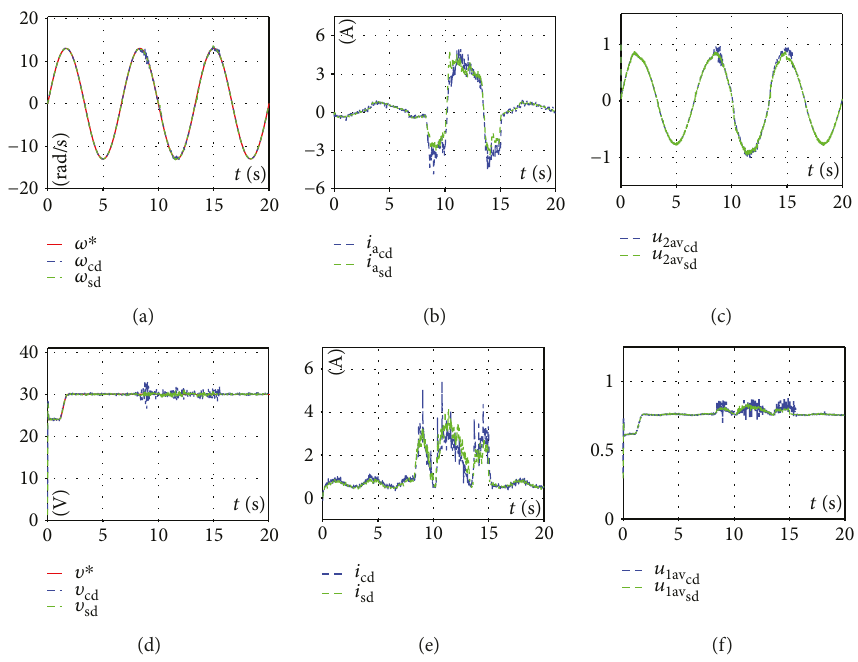
Figure 4: Experimental results of controls (11), (12) and (47), (48) when an abrupt load change is applied.